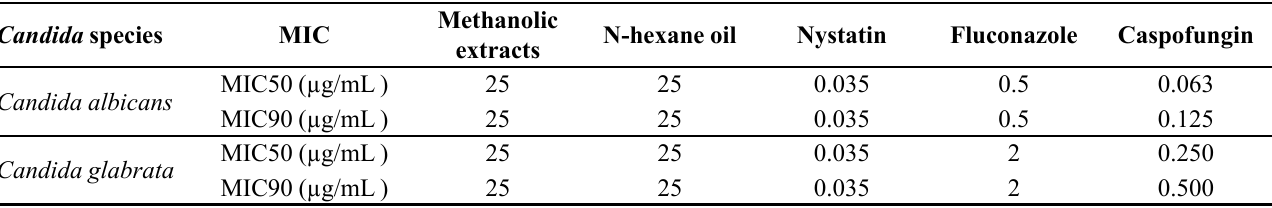
TABLE II - MIC50 and MIC90 values of methanolic and N-hexane extracts of sesame seeds and antifungals for the isolated Candida species